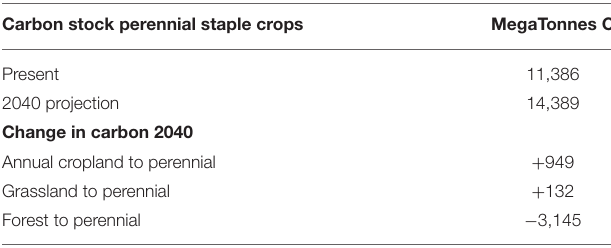
TABLE 4 | Global carbon stocks and changes from perennial staple